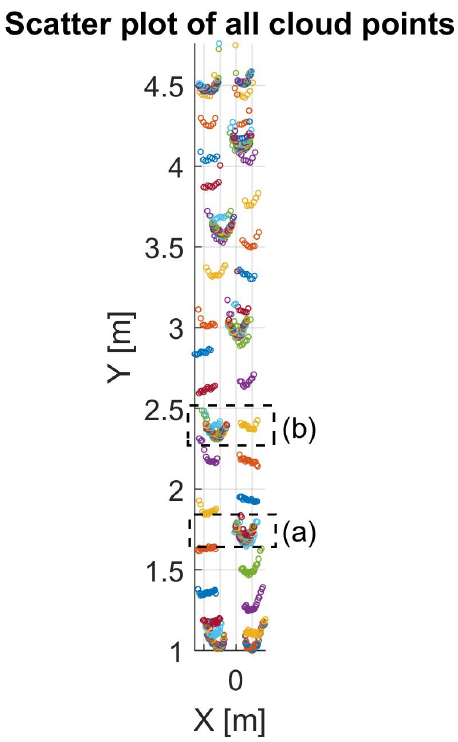
Figure 8. Scatter plot of all the cloud points during walking: ( a ) the identified single-support leg of the first step; ( b ) the identified single-support leg of the second step.